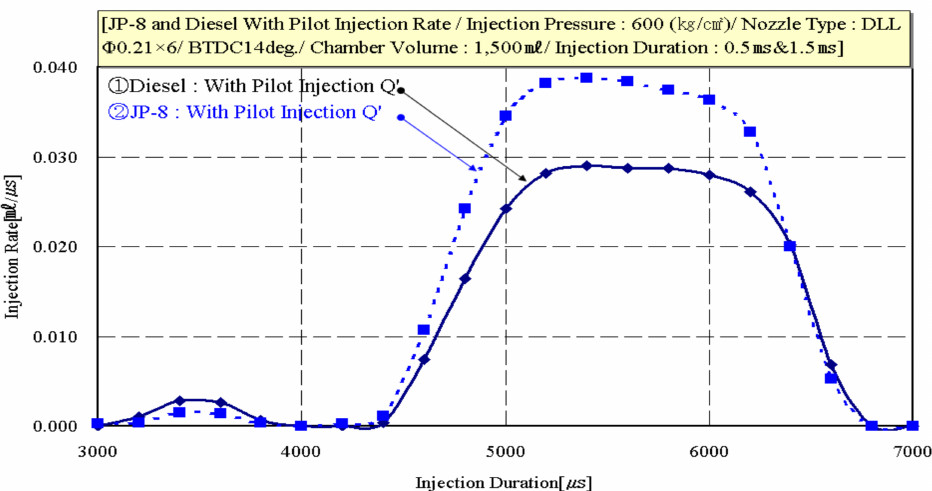
Figure 10. Injection rate characteristics during injections of diesel and JP-8 with pilot